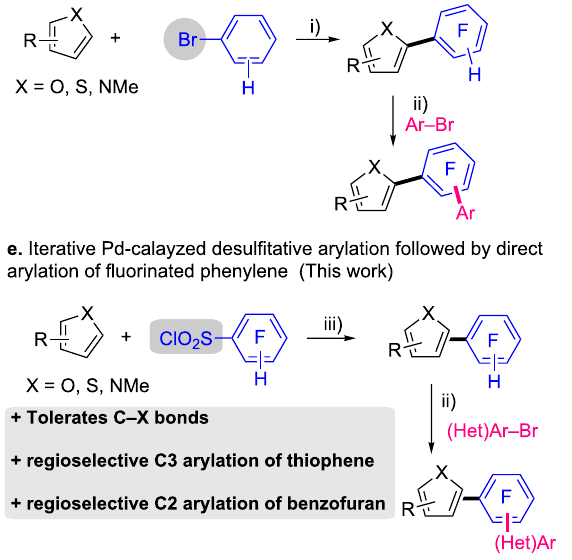
Figure 1: Different pathways for the synthesis of π -conjugated mole- cules incorporating fluorinated phenylene units. i) Pd(OAc) 2 , KOAc, DMA, 150 °C. ii) PdCl(C 3 H 5 )(dppb), KOAc, DMA, 150 °C ; ii) PdCl(C 3 H 5 )(dppb), KOAc, DMA, 150 °C; iii) PdCl 2 (CH 3 CN) 2 , Li 2 CO 3 , 1,4-dioxane, 140